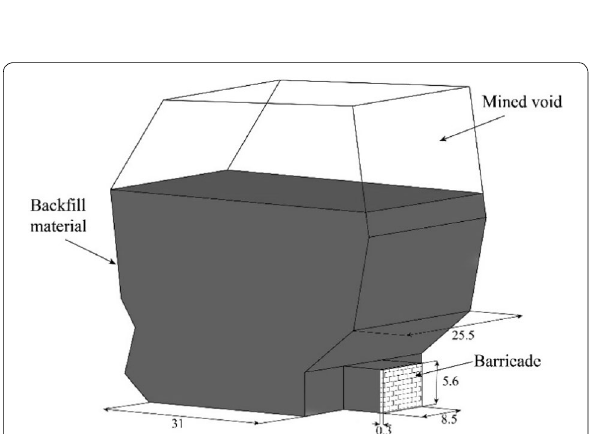
Fig. 2 3D schematic diagram for the filling of Stope 685N20 (dimension in m).